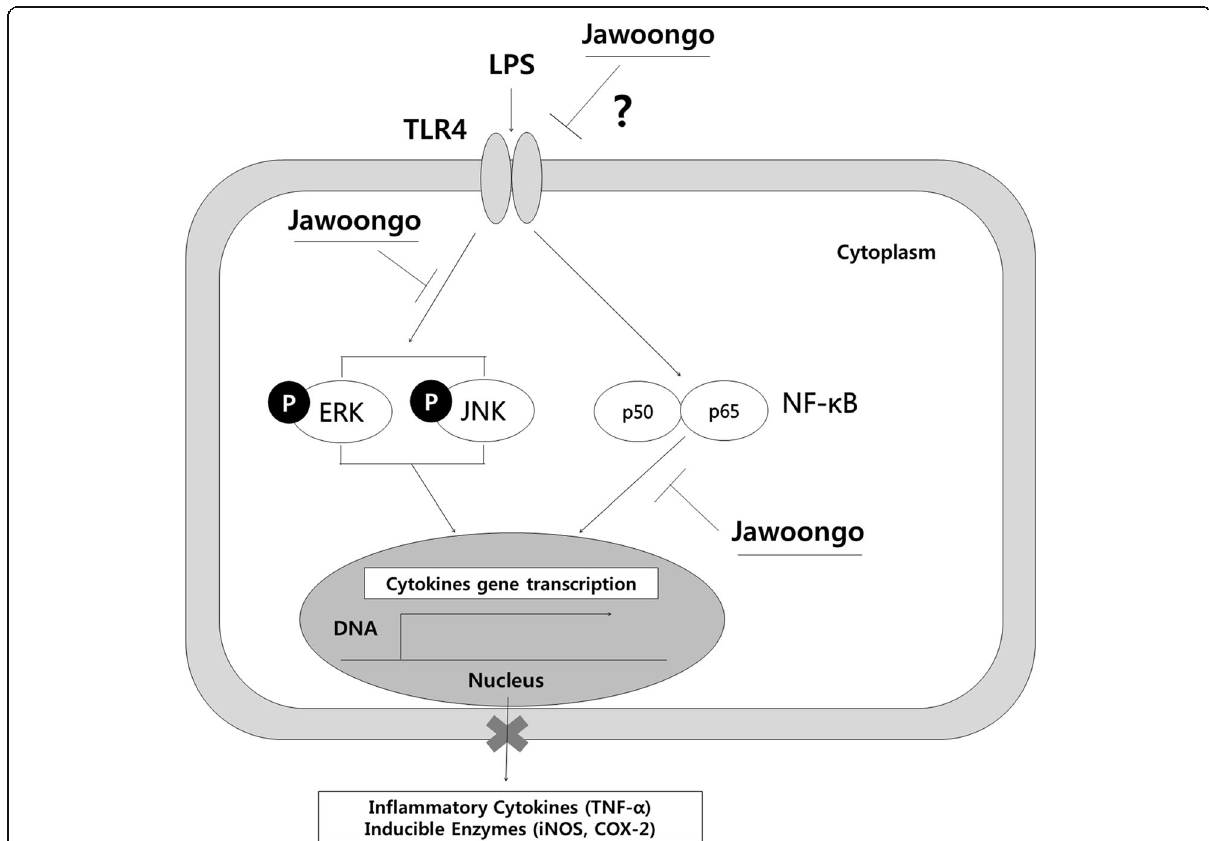
Fig. 11 Pathway diagram of the mechanism of histamine inhibition of ERK, JNK and NF-kB activation. RAW264.7 cells and Splenocyte activated with a LPS agonist activated the MEK/ERK MAPK signaling and NF-kB signaling cascade to induce production of TNF. Jawoongo inhibited MEK/ ERK and NF-kB activation and suppressed production of